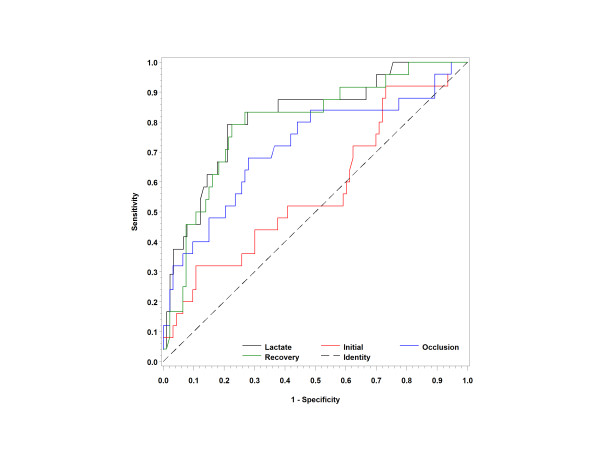
Receiver operating characteristic curves for mortality. The receiver operating characteristic (ROC) curves for the initial StO2, ischemic slope, recovery slope and serum lactate measurements as predictors of in-hospital mortality are shown.